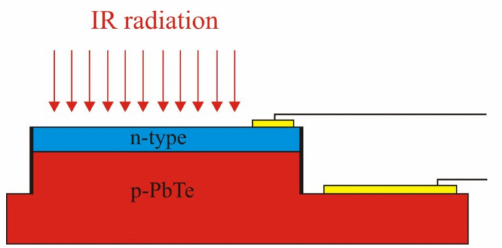
Figure 4. Schematic view of the In-doped PbTe p-n photodiode. The radiation from a blackbody source ( T = 1000 K) chopped at a 1000 Hz frequency